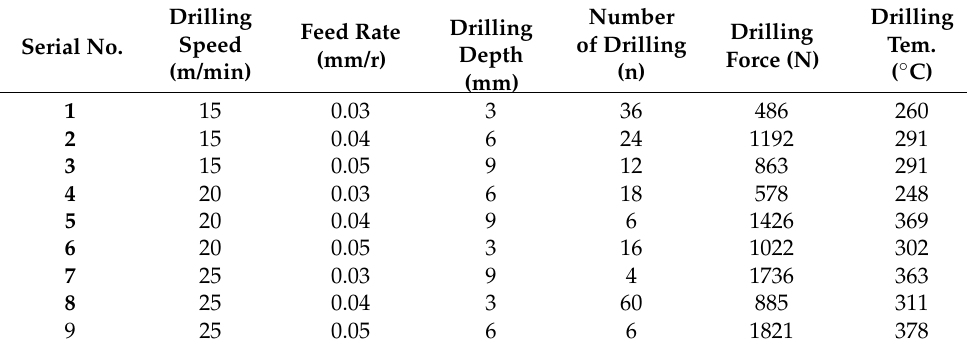
Figure 3. Drilling experiment workpiece. Table 7. Orthogonal drilling experiment results.